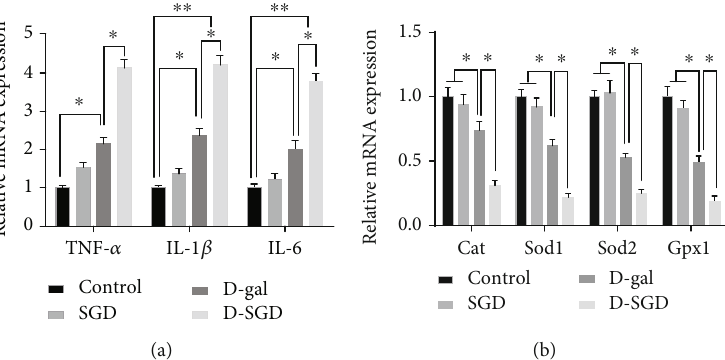
Figure 1: E ff ects of serine de fi ciency on the mRNA expression of genes encoding in fl ammatory cytokines and antioxidant enzymes in D- galactose-treated mice. (a) Relative mRNA expression of TNF- α , IL-1 β , and IL-6 in the brain; (b) relative mRNA expression of Cat , Sod1 , Sod2 , and Gpx1 in the brain. Data were expressed as mean ± SEM , n = 8 . ∗ P < 0 : 05 , ∗∗ P < 0 : 01 Table 4: E ff ects of serine de fi ciency on α -diversity indexes of microbiota in D-galactose-induced aging mice. Index